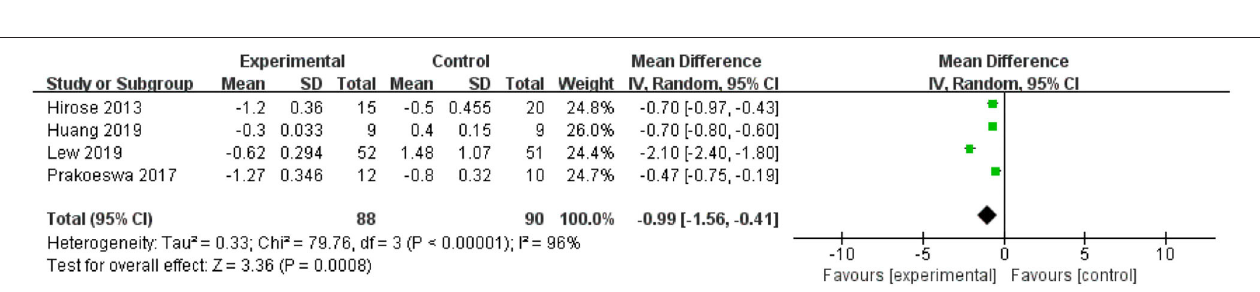
FIGURE 4 | Forest plot of effect of Lactobacillus plantarum on TNF- α . SD, standard deviation; Total, sample size of each group; Mean Difference, the mean value of the experimental group minus that of the control; 95% CI, 95% confidence intervals.